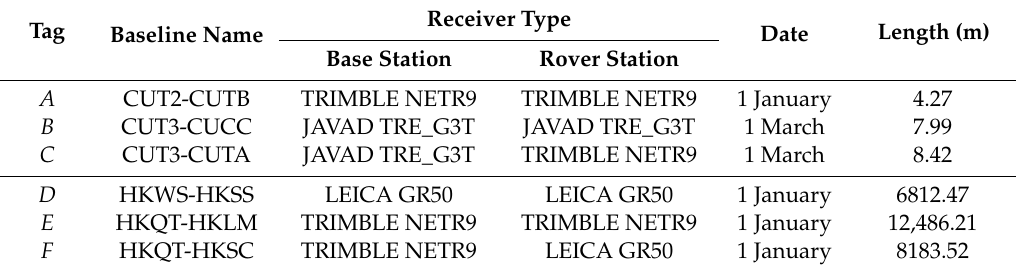
Table 1. Configuration of used static